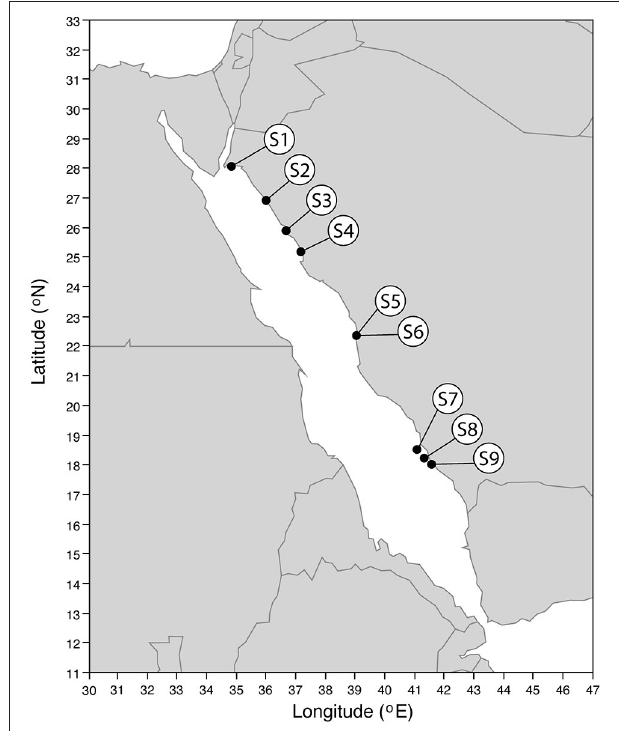
FIGURE 1 | Location of the seagrass stations sampled along the Saudi coast of the Red Sea.